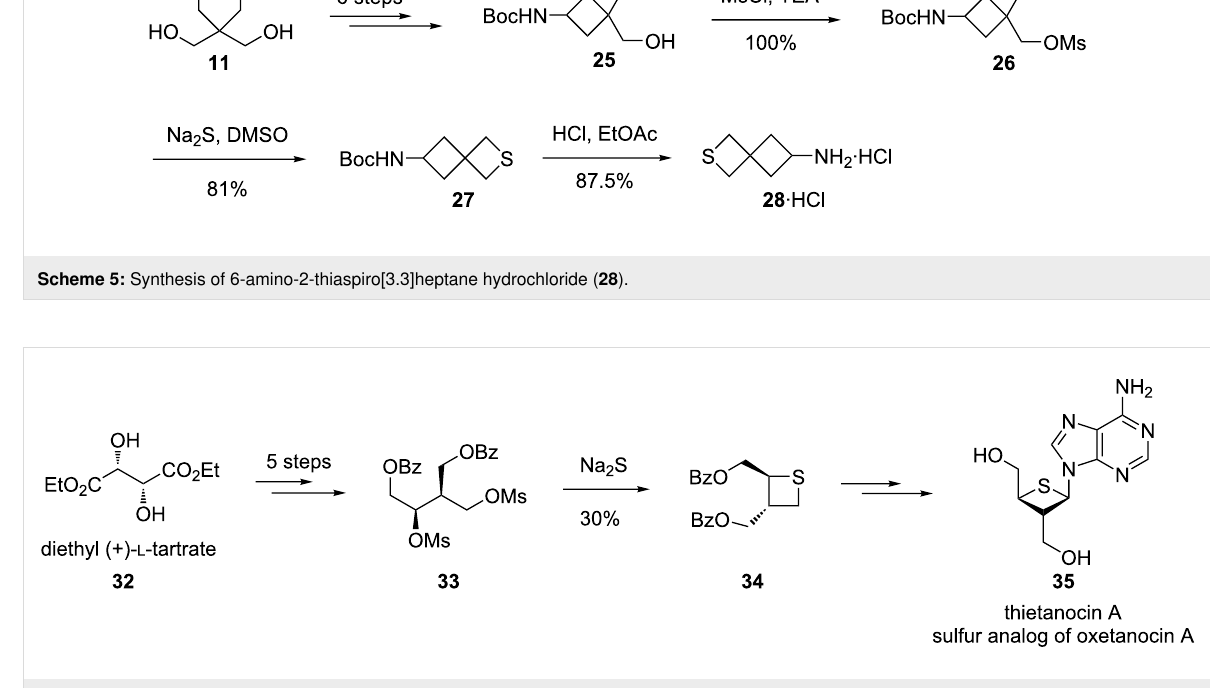
Scheme 7: Synthesis of an optically active thietane nucleoside from diethyl L-tartrate ( 32 ).